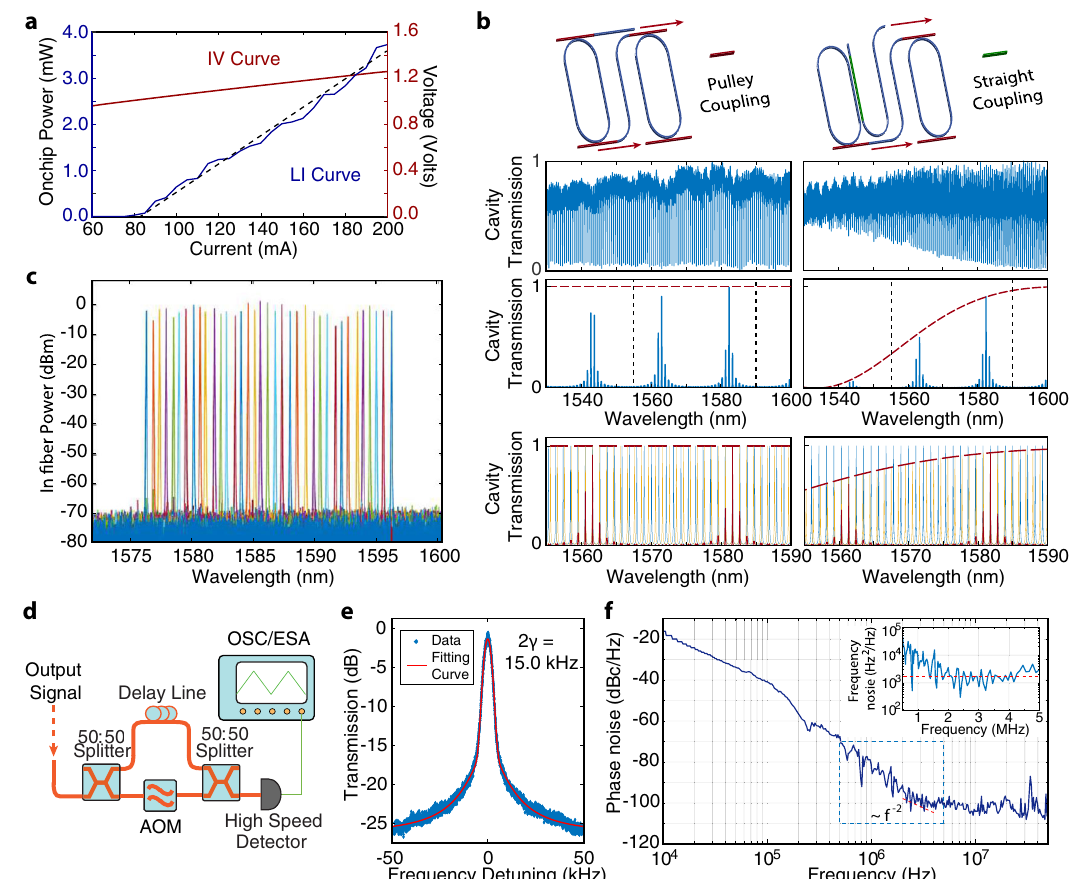
Fig. 2 | Power, linewidth, and wavelength tuning characteristics of the laser. a MeasuredLIandIVcurvesofthelaser. b SchematicoftheVernierringstructure: the left one with pulley coupling and the right one with straight coupling repla- cing the output pulley bus waveguide. Second row: Measured transmission spectrumofbothpulleyandstraightcoupling.Thirdrow:Simulatedtransmission spectrumoftheVernierstructureoutput.Left:withpulleycouplingappliedtoall ports. Right: with output port replaced by straight coupling. Red dashed lines show the power transfer limited by the coupling rate. c Thermal-optic tuning spectrum of the laser wavelength recorded by an optical spectrum analyzer. d Setup schematic of delayed self-heterodyne phase noise measurement. AOM: